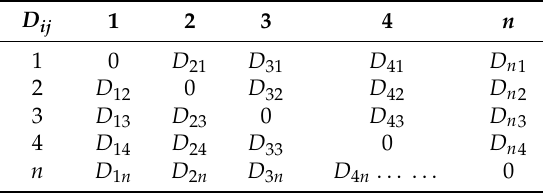
Table 2. Matrix of